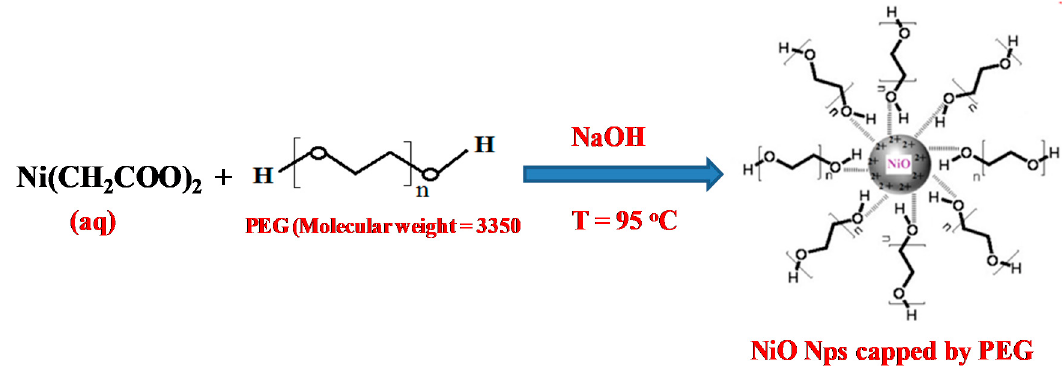
Figure 1. Structural impact of nickel acetate and polyethylene glycol(PEG) reaction.